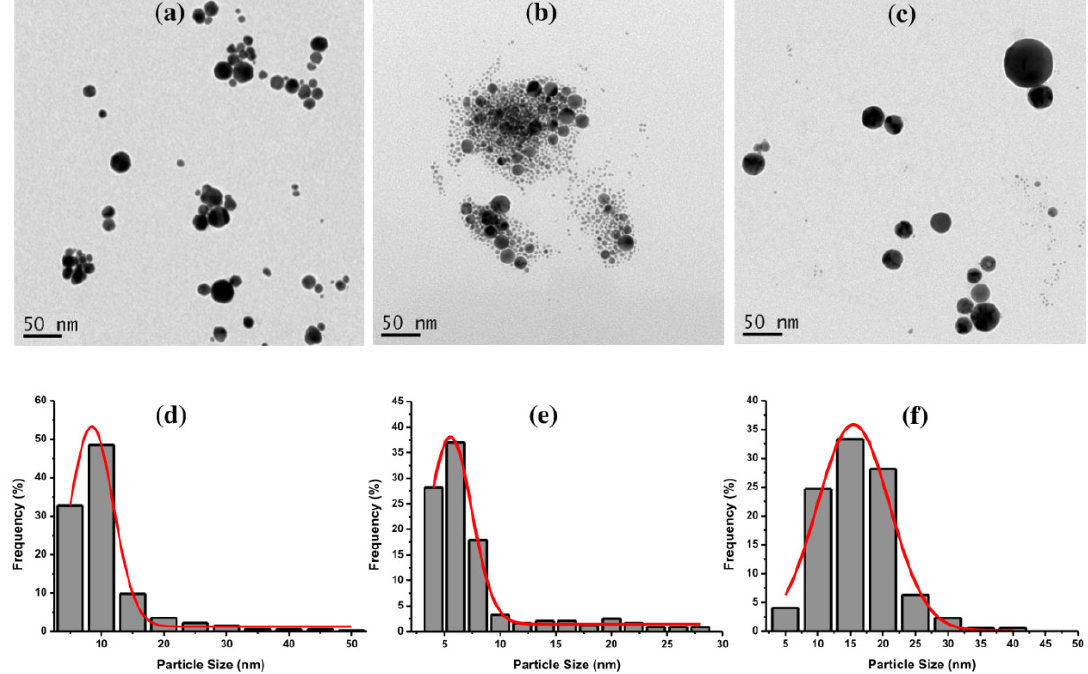
Figure 4. The TEM images of Au NPs using ( a ) CTAB, ( b ) TX-100, and ( c ) SDS, and their size distributions ( d ) CTAB, ( e ) TX-100, and ( f) SDS with the laser fluence of 0.4 J cm −2 . The ablation time was 20 min, and the surfactant concentration was 10 mM.